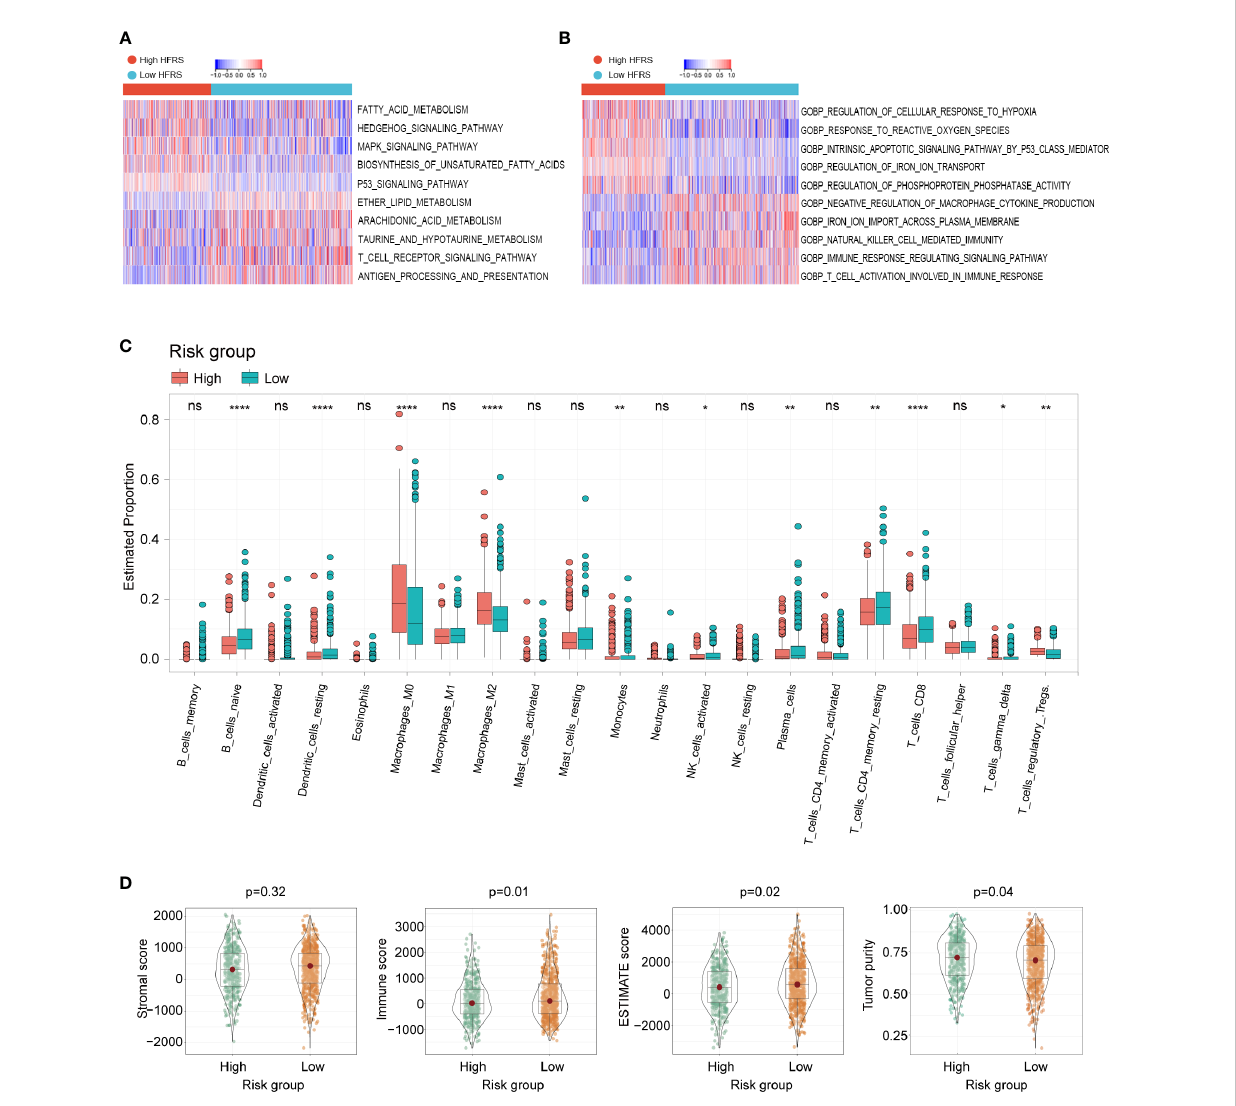
FIGURE 6 The relationship between tumor immune cell in fi ltration and HFRS in BC patients. (A, B) KEGG analyses and GO analyses for hypoxia and ferroptosis- related genes of the high- and low-HFRS groups. (C) Comparison of the immune cells in fi ltration between the high- and low-HFRS groups of the TCGA cohort by the CIBERSORT algorithm. (D) The violin plots show signi fi cant difference in stromal, immune ESTIMATE scores and tumor purity of between high- and low-HFRS risk groups in TCGA cohort. (*p< 0.05; **p< 0.01; ****p< 0.0001, n.s., not signi fi